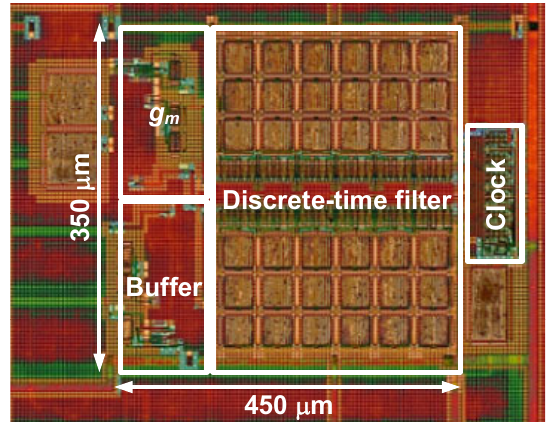
Figure 7. Chip photomicrograph.